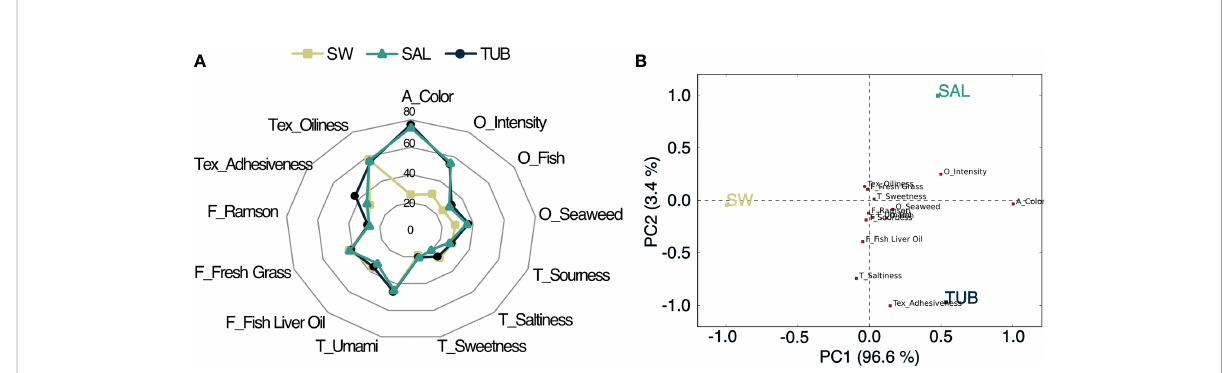
FIGURE 2 (A) Sensory pro fi le showing the mean values, and (B) Principle Component Analysis (PCA) of the sensory attributes for Ulva fenestrata cultivated in seawater control (SW) and the two herring production process waters salt brine (SAL) and tub water (TUB). In the PCA, the fi rst main component (PC1) accounts for 96.6% of the data variation and the second main component (PC2) accounts for